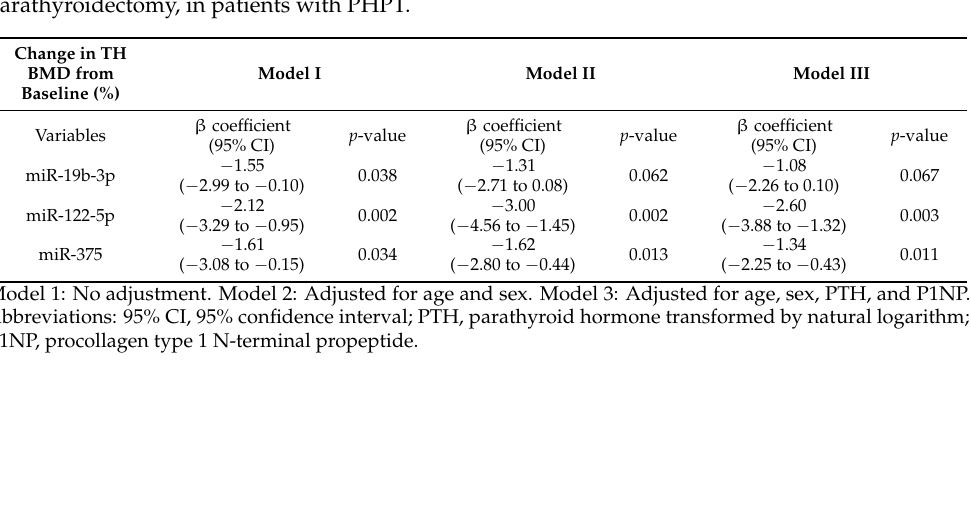
Table 3. Multivariable regression models for TH BMD change from baseline (%), 1 year after parathyroidectomy, in patients with